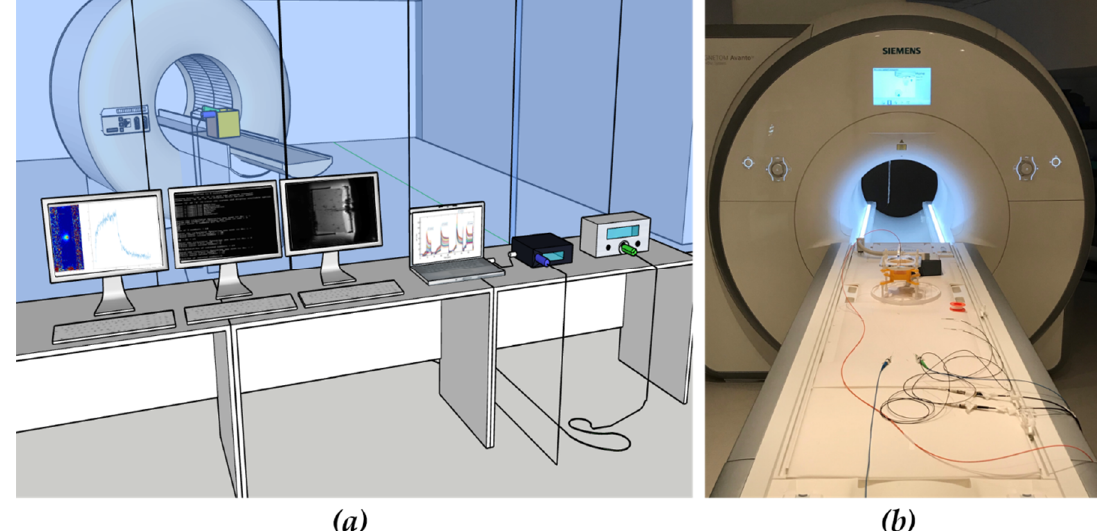
Figure 4. ( a ) Experimental setup for performing laser ablation on an agar gel phantom while monitoring the temperature with FBG sensors and MRTI. The laser system and spectrum analyzer are placed in the control room from which is possible to see the MR scanner. The operator console and real time reconstruction pipeline are also represented, the temperature map is finally displayed on dedicated thermometry software; ( b ) photograph of setup arrangement within the Magnetic Resonance scanner room.